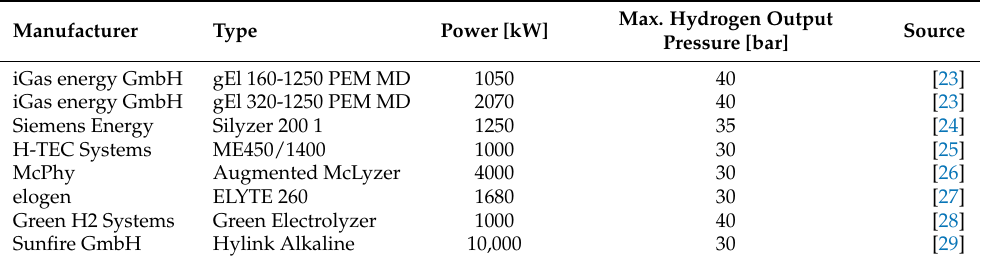
Table 1. Overview of the maximum hydrogen output pressure of currently available PEM and alkaline pressure electrolysers in the power range from 1 MW based on manufacturer